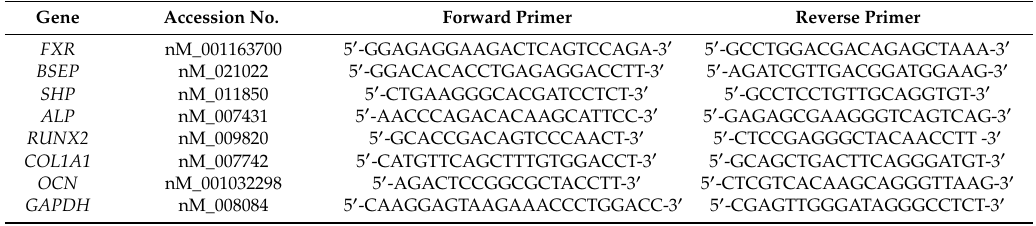
Table 2. Nucleotide sequences of primers used in